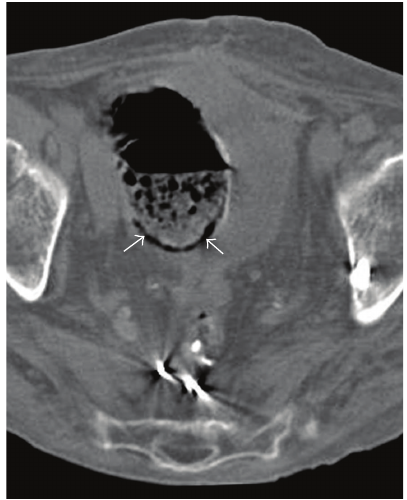
Figure 2: Axial noncontrast image of the pelvis shows a curvilinear collection of gas in the dependent wall of the large bowel (arrows). The dependent location of the gas helps distinguish pneumatosis from intraluminal